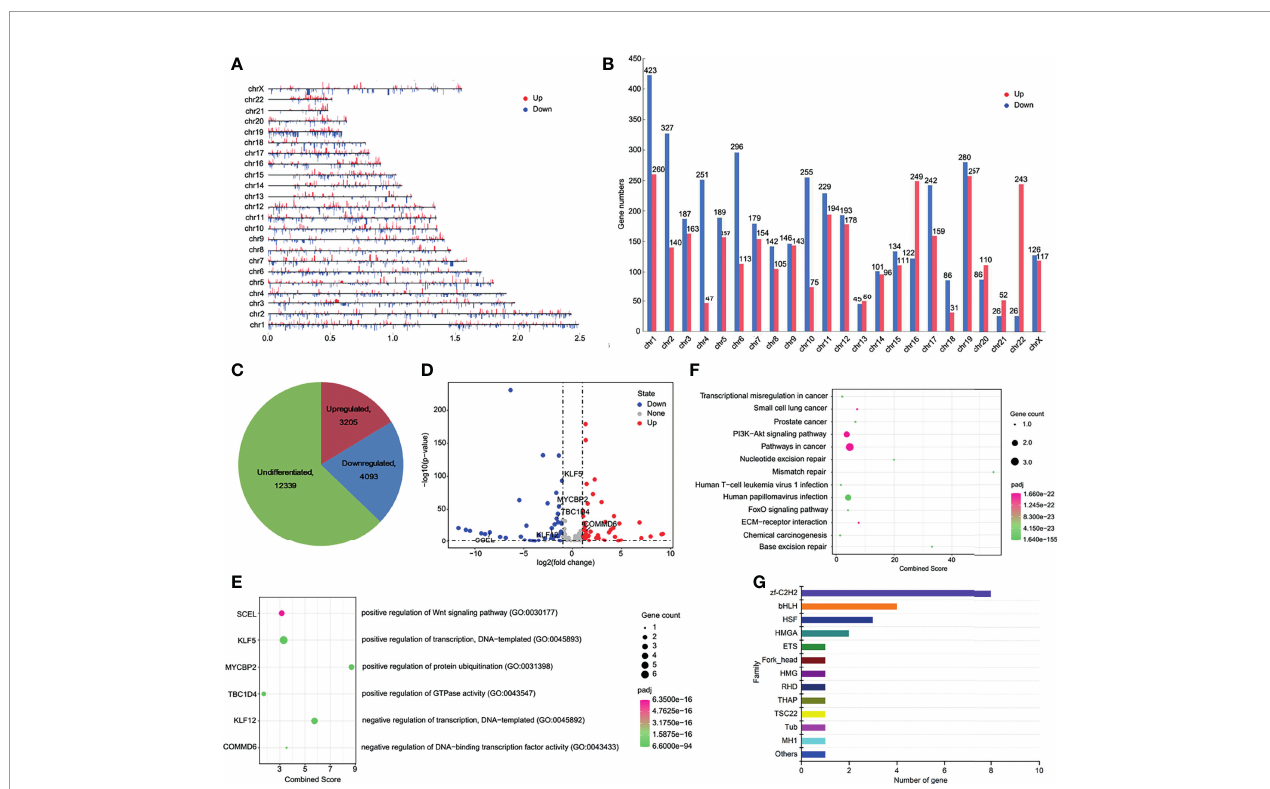
FIGURE 4 | HPV16-LINC00393 integration altered gene expression in SiHa cells. (A) The distribution of differential expressed genes in each chromosome. (B) The statistical graph showed the numbers of differential expressed gene in each chromosome. (C) The distribution of transcription changes in SiHa as compared with Ect1/E6E7 by RNA-seq. (D) Volcano map showing the differentially expressed genes within the chromosome 13 between SiHa and Ect1/E6E7. (E) Integrated analysis of HPV16-LINC00393 integration associated genes (left panel) and functional annotation (right panel). (F) KEGG enrichment analysis based on the Metascape platform. (G) Analysis of differential transcription factor. The vertical axis shows the different transcription factor families and the horizontal one shows the number of genes annotated to the transcription factor